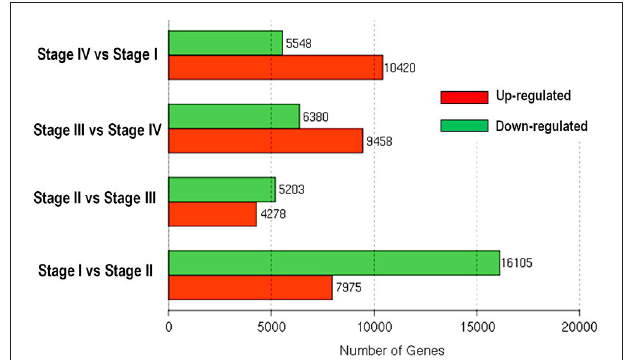
FIGURE 5 | Numbers of differentially expressed genes involved in phase changes during bud development of